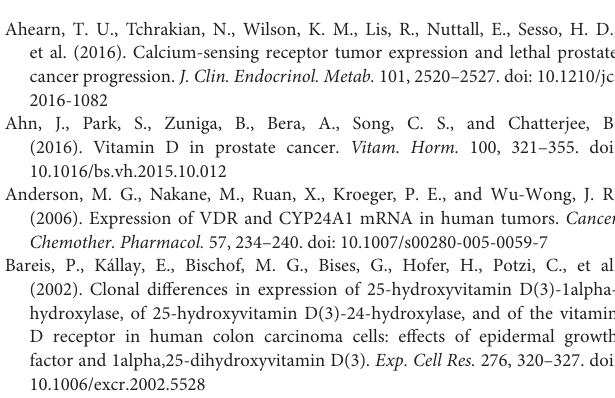
patients might therefore have a higher risk to develop